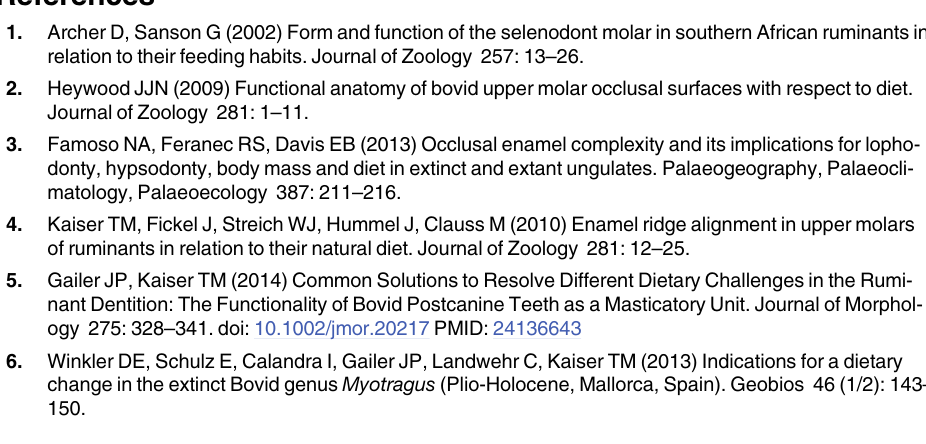
S1 Table. Voxel size per specimen. The scans included the whole upper or lower jaw. If possi- ble, mandibles were separately scanned. As size is very different between specimens, kV and μ A settings vary. Hence the obtained resolution is not always the same. S2 Table. Results of Shapiro-Wilk normality test testing against assumption of normality. Each variable (enamel content per tooth position) rejects the hypothesis; hence none violates the assumption of normality. W = test value, p = significance level. S3 Table. Results of robust Brown-Forsythe Levene-type test Bartlett ’ s test. There is no sig- nificant difference in variances, hence we assume variance homogeneity. t , K-squared = test value, p = significance